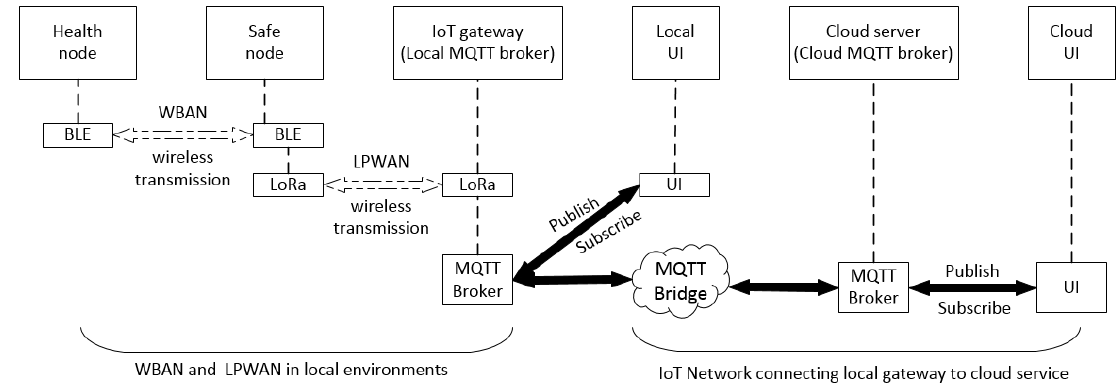
Figure 2. Network implementation from WBAN to the cloud